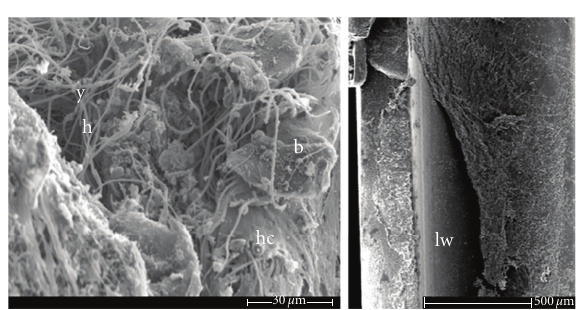
Figure 1: Scanning electron microscopy images of wild type Candida albicans biofilms developed in vivo in the denture model (left panel) and in the subcutaneous model (right panel). Elements such as hyphal cells (h), yeast cells (y), bacterial cells (b), host cells (hc) and catheter lumen wall (lw) are highlighted. Images were adapted from the work of Nett et al. [67], and S. Kuchar´ıkov´a and P. Van Dijck (MCB Laboratory, VIB, K.U. Leuven, unpublished data),